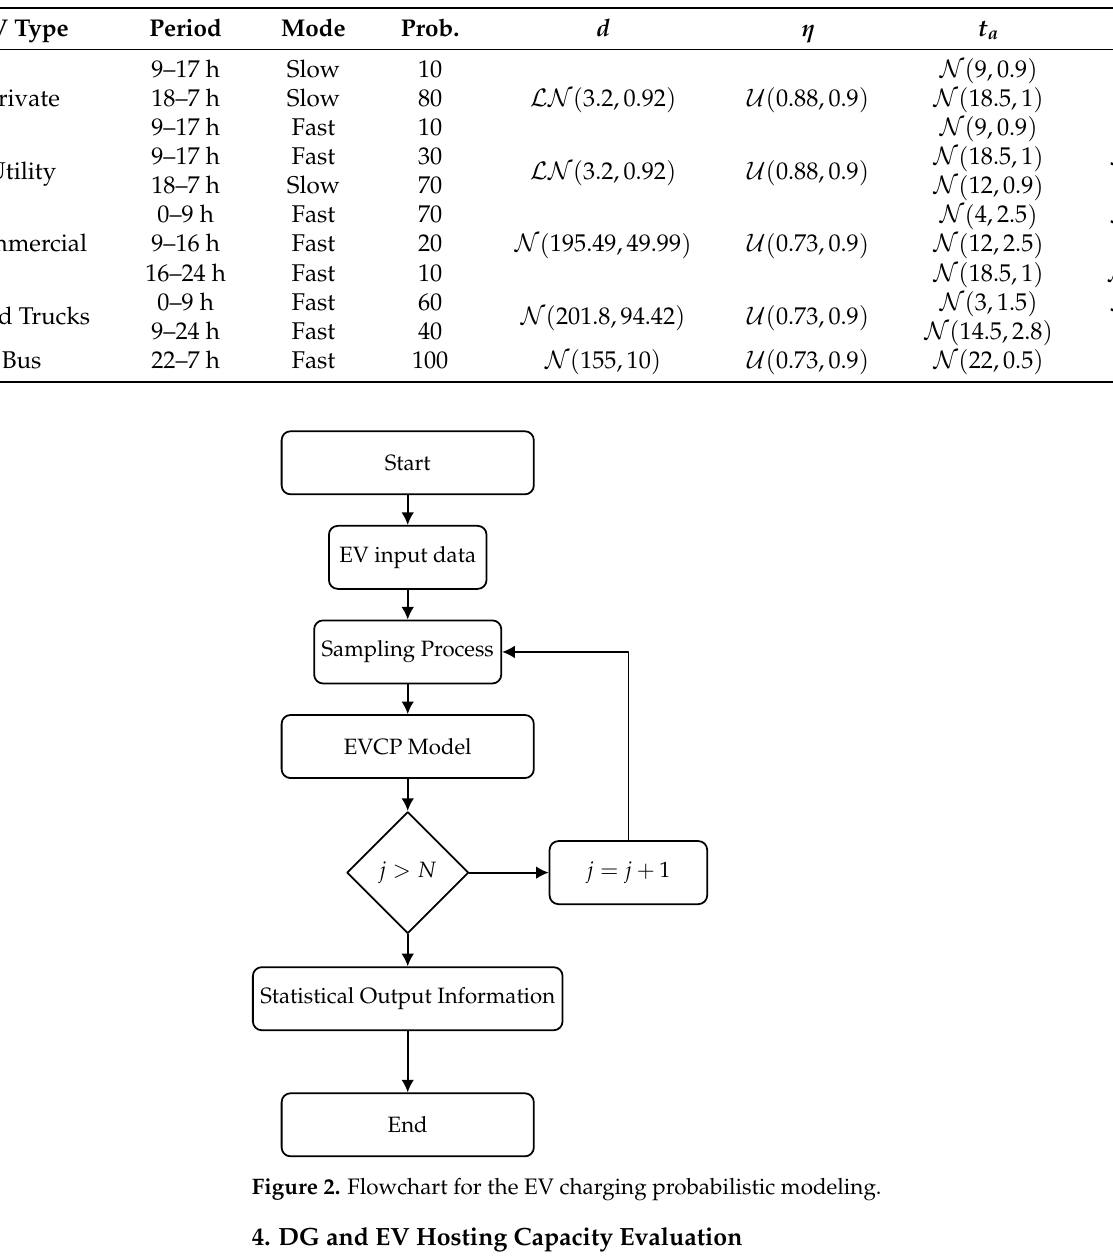
Table 1. Charging EV parameters for probabilistic modeling [3,5]. N ( µ , σ ) is a Gaussian distribution with parameters µ (mean) and σ (standard deviation); LN ( µ , σ ) is the log normal distribution, and U ( a , b ) is a uniform distribution with parameters a and b .